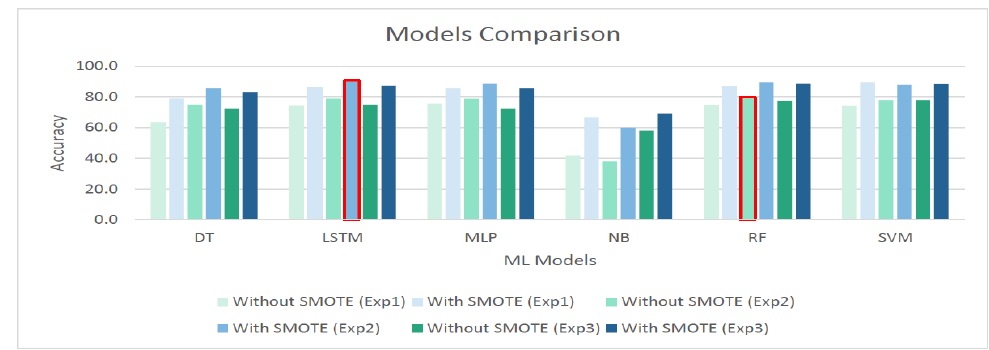
Figure 15. Experiments Comparison.